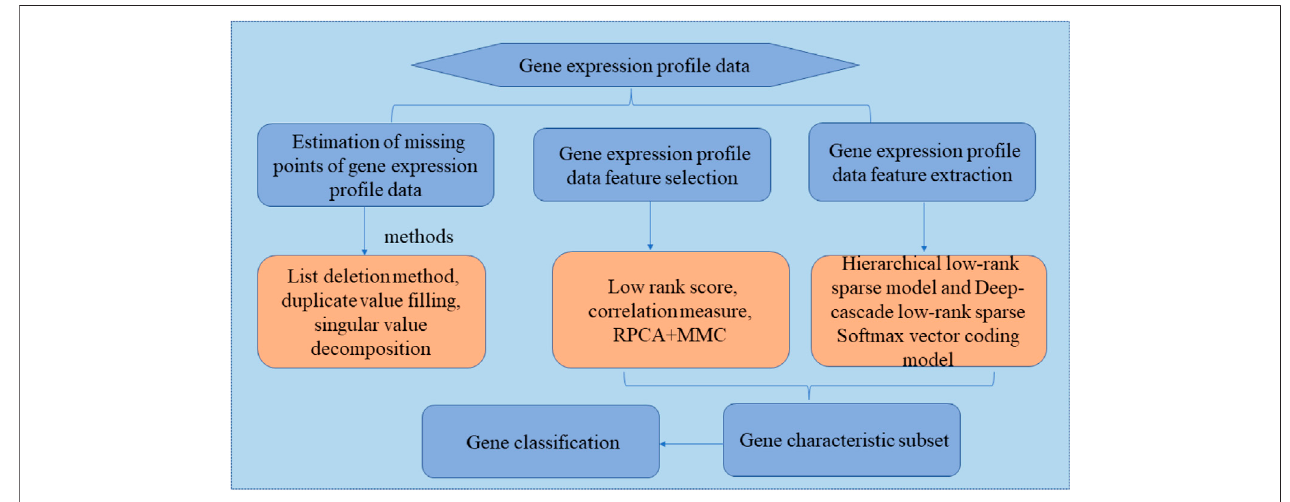
FIGURE 4 | Research procedure for gene database analysis based on low-rank sparse